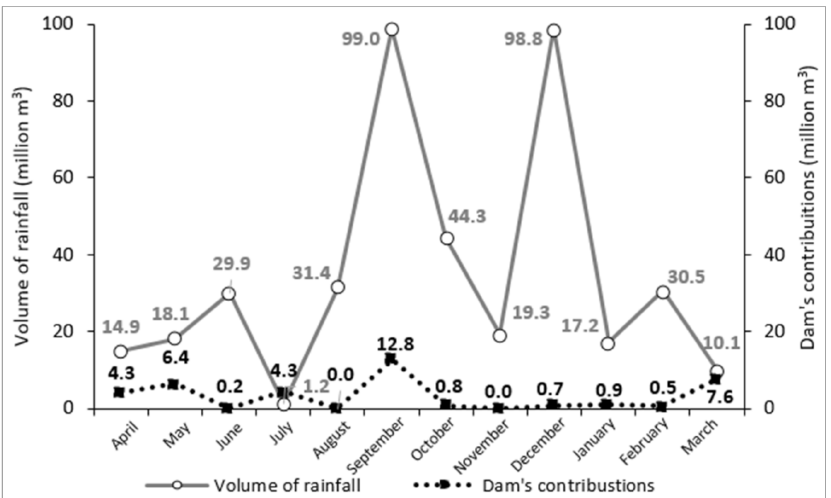
Figure 3. Correlation between volume of rainfall and dam’s